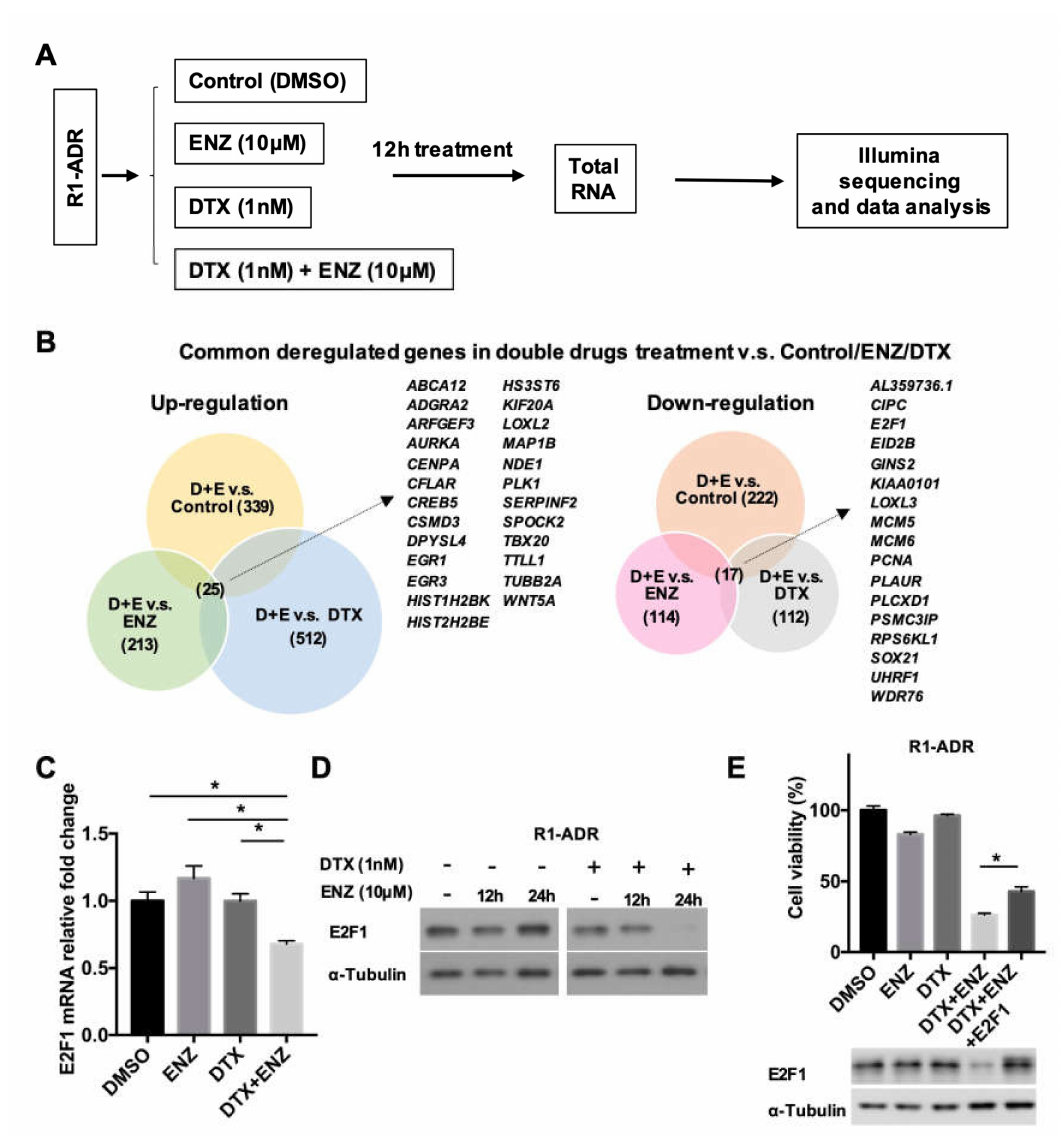
Figure 2. Di ff erential gene expression in response to DTX-ENZ combined treatment. ( A ) Flowchart of RNA sample preparation and RNA-seq. ( B ) Analysis of common deregulated genes in double drugs v.s. Control or ENZ or DTX group. ( p < 0.05, FDR < 0.25, fold change > 1.4) ( C ) Expression of E2F1 in R1-ADR cells 12 h after drug treatment were determined by qRT-PCR. Error bars, S.D. * p < 0.05. ( D ) Protein expression of E2F1 in R1-ADR cells 12 and 24 h after drug treatment were determined by western blot. ( E ) Re-expressed E2F1 partially rescued DTX + ENZ induced growth inhibition in R1-ADR cells. Cell growth was determined by CCK-8 assays 72 h after re-introduced exogenous E2F1 in the presence of DTX and ENZ. Error bars, S.D. * p <